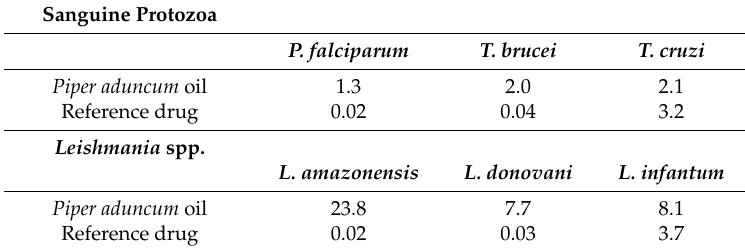
Table 3. Antiprotozoal activity, IC 50 ( µ g/mL) of the essential oil from Piper aduncum L. collected in Havana,